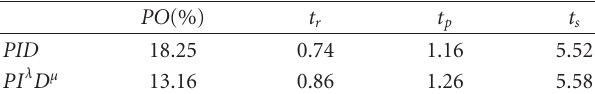
Table 4: Time response parameters of the system under the action of the PID and PI λ D μ